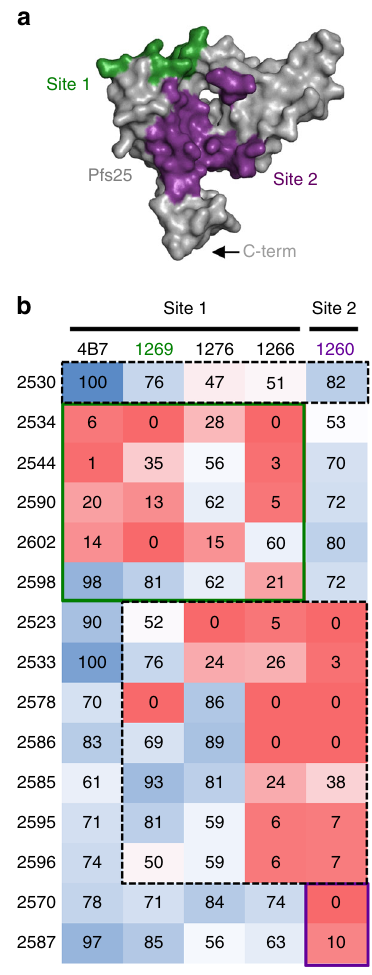
Fig. 2 Epitope binning of human anti-Pfs25 antibodies. a Surface representation of Pfs25 showing the two previously characterized epitopes: Site 1 (1269, green) and Site 2 (1260, purple), and the C-terminus (C-Term) where Pfs25 was fused to the VLP. b Previously characterized Fabs are listed along the top and are the primary Fabs in the BLI competition assay. Secondary (competing) human Fabs are to the left. Reported scores are a percentage of total potential binding of that antibody, and therefore higher numbers (blue) display low amounts of competition, while low numbers (red) exhibit greater competition. Any experiment with >100% binding was given a score of 100, while negative values were given a score of 0. Human antibodies that fi t previously de fi ned epitopes Site 1 and Site 2 are outlined in green and purple, respectively. Potential novel epitope bins are highlighted by a dashed-line concentration of 100 µg/mL. Nine of these mAbs (2530, 2534, 2544, 2578, 2586, 2587, 2595, 2598, and 2602) demonstrated